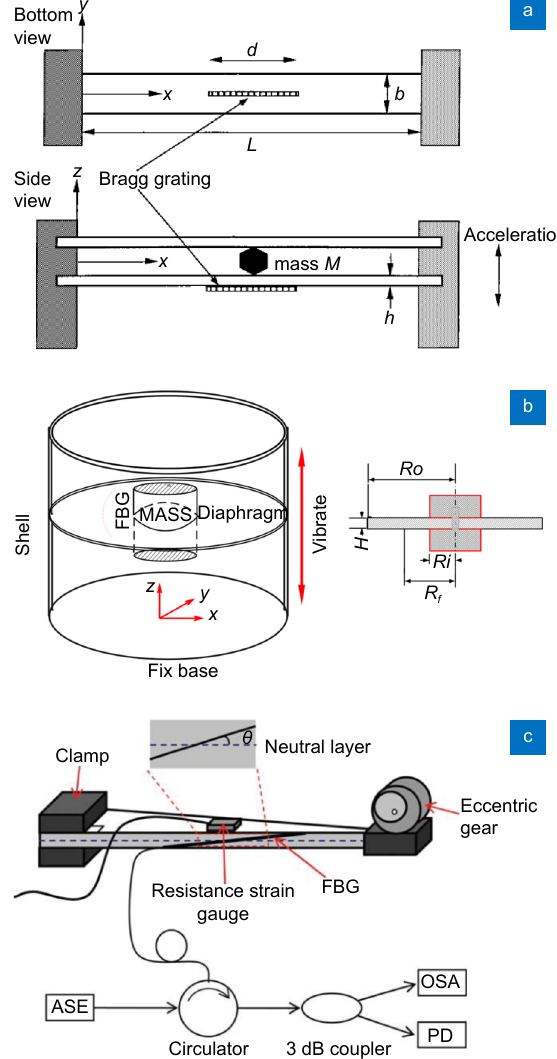
Fig. 16 | ( a ) Simplified model of an optical fiber unembedded FBG based accelerometer. ( b ) Schematic of an optical fiber unembedded FBG based accelerometer. ( c ) An optical fiber unembedded FBG based accelerometer. Figure reproduced with permission from: (a) ref. 82 and (b) ref. 78 , IEEE; (c) ref. 81 , John Wiley and